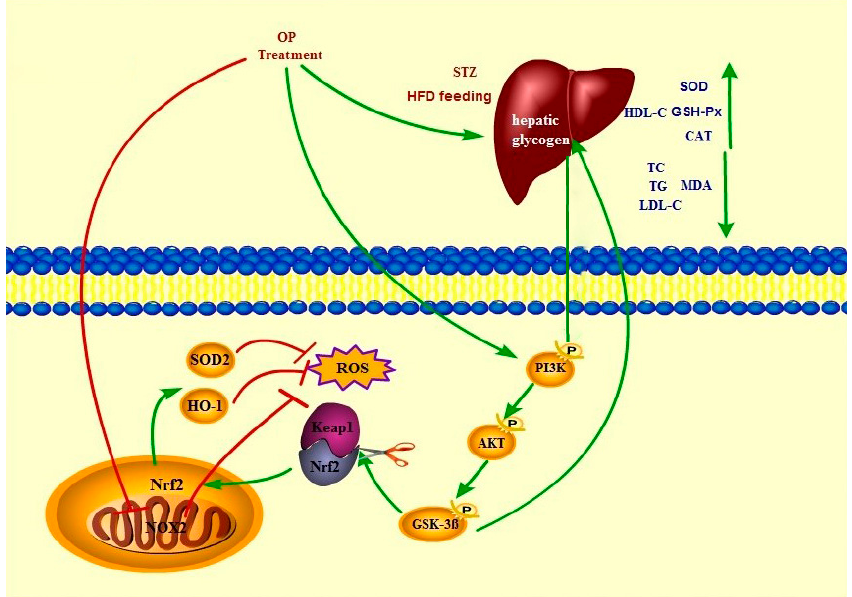
Figure 10. Proposed OP anti T2DM-like pathways.